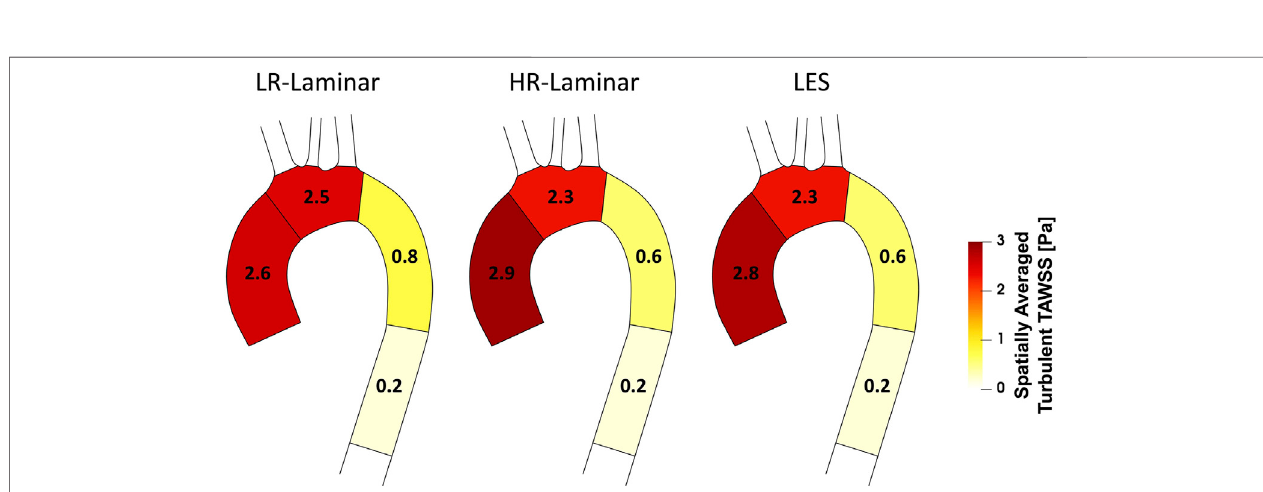
FIGURE 8 | Top row: Time-averaged turbulent wall shear stress (Turbulent-TAWSS) contours for LR-Laminar, HR-Laminar and LES simulations. Bottom row: Absolute difference in turbulent-TAWSS values for LR- and HR-Laminar simulations, relative to the LES simulation. Locations of interest are circled.